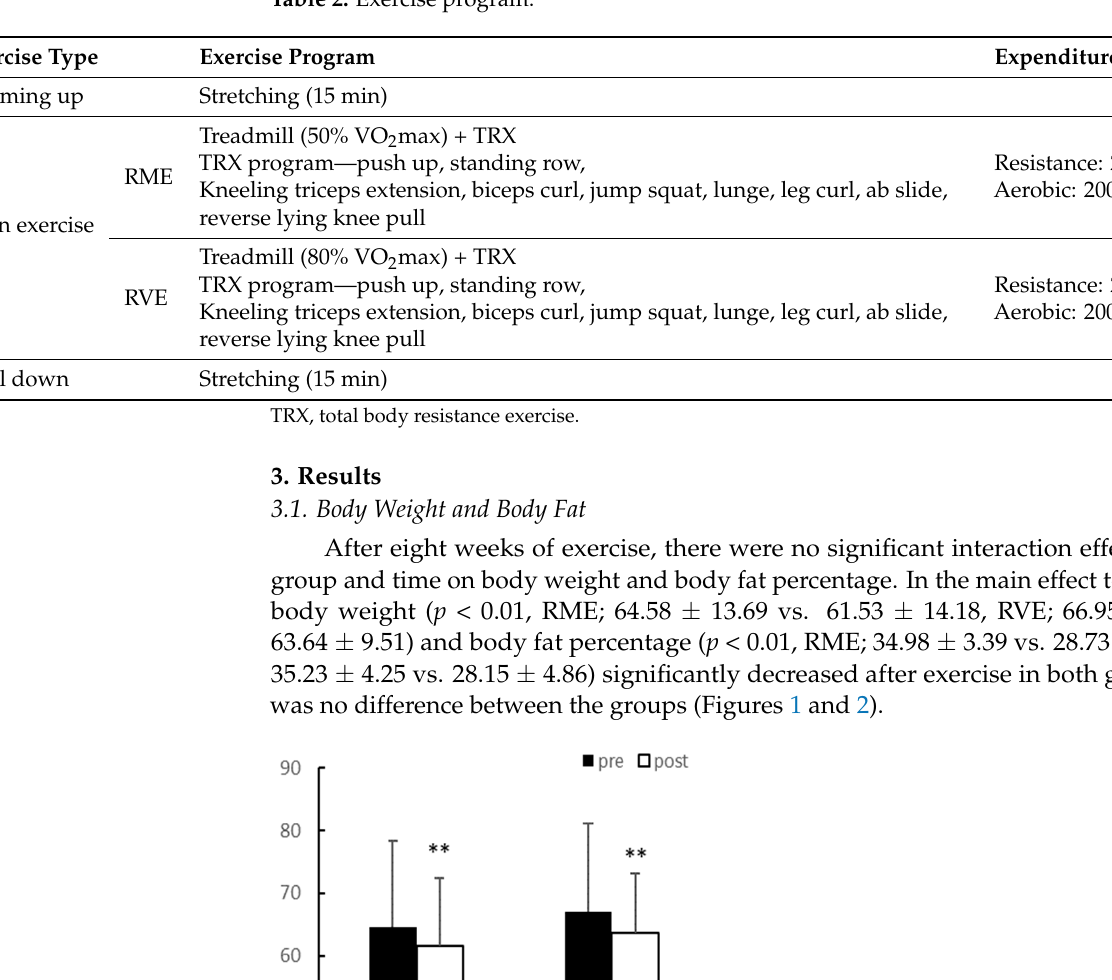
Table 2. Exercise program.